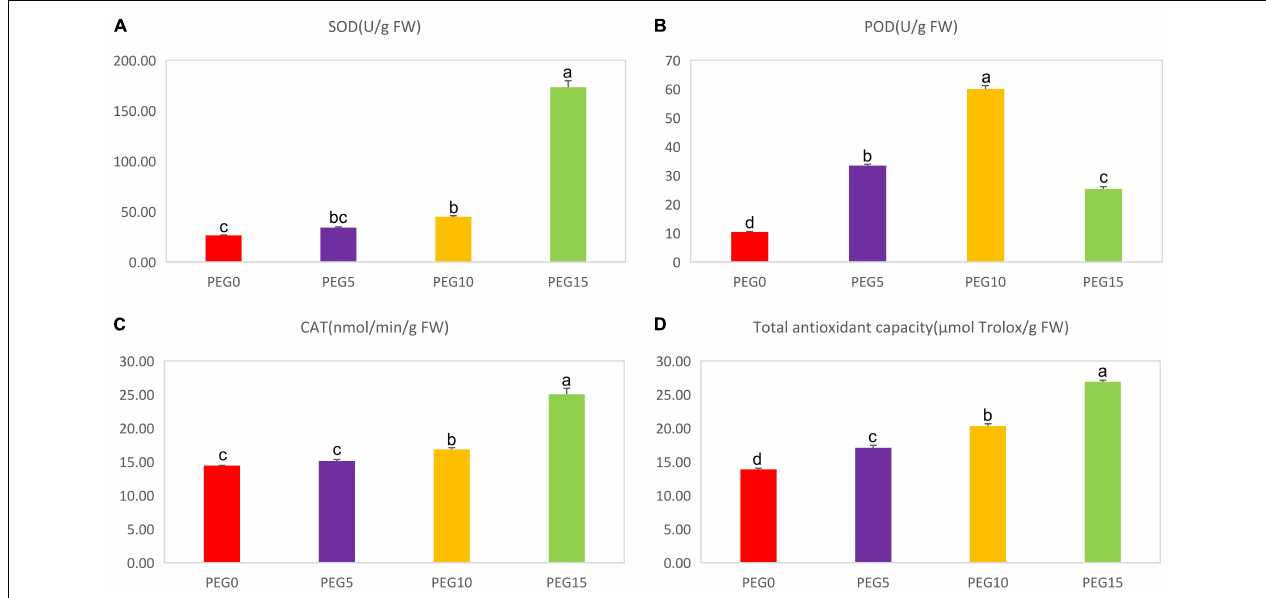
FIGURE 4 | Changes of the antioxidant enzyme activities under different drought stress conditions. (A–D) The contents of superoxide dismutase (SOD), peroxidase (POD), catalase (CAT), and total antioxidant capacity (TAC) under different drought stress conditions, respectively. Different letters indicate the significant difference at the 0.05 level.